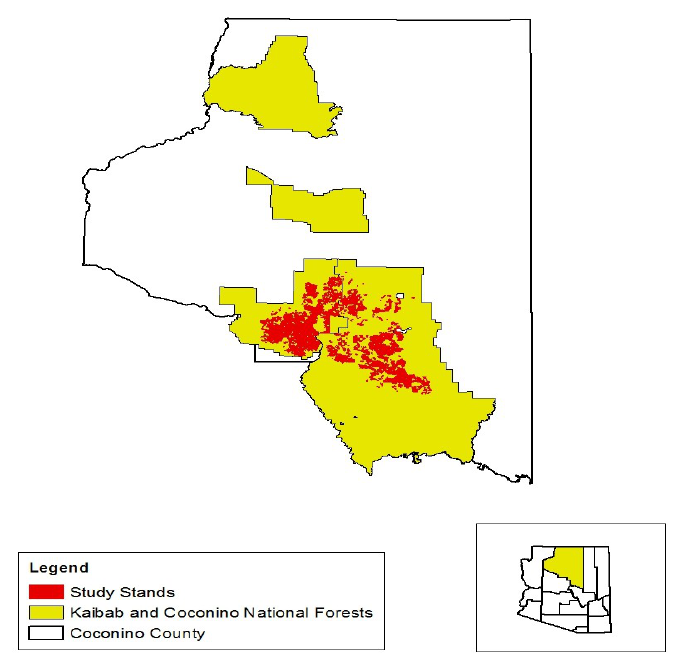
Figure 1. Study area, Coconino County, Northern Arizona, United States. Stands (red) are distributed across the lower-Kaibab and upper-Coconino National